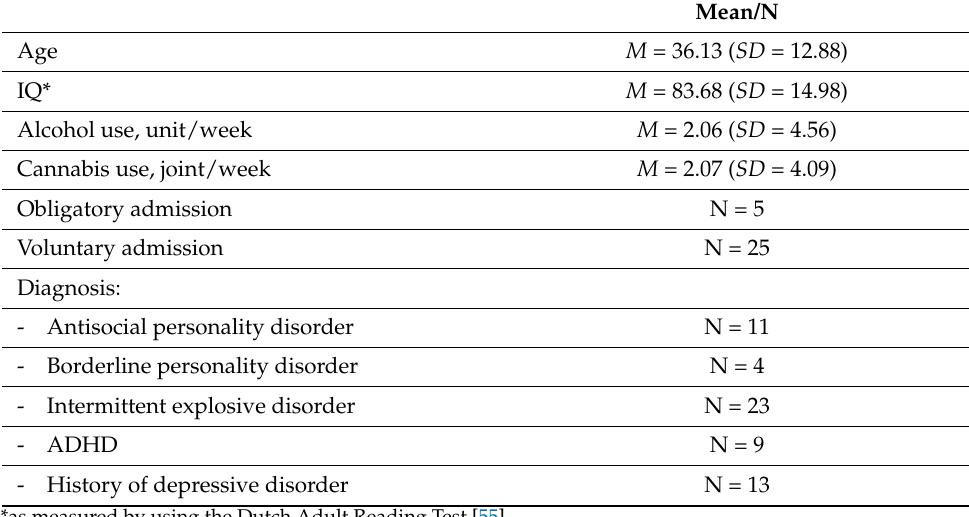
Table 2. Demographic